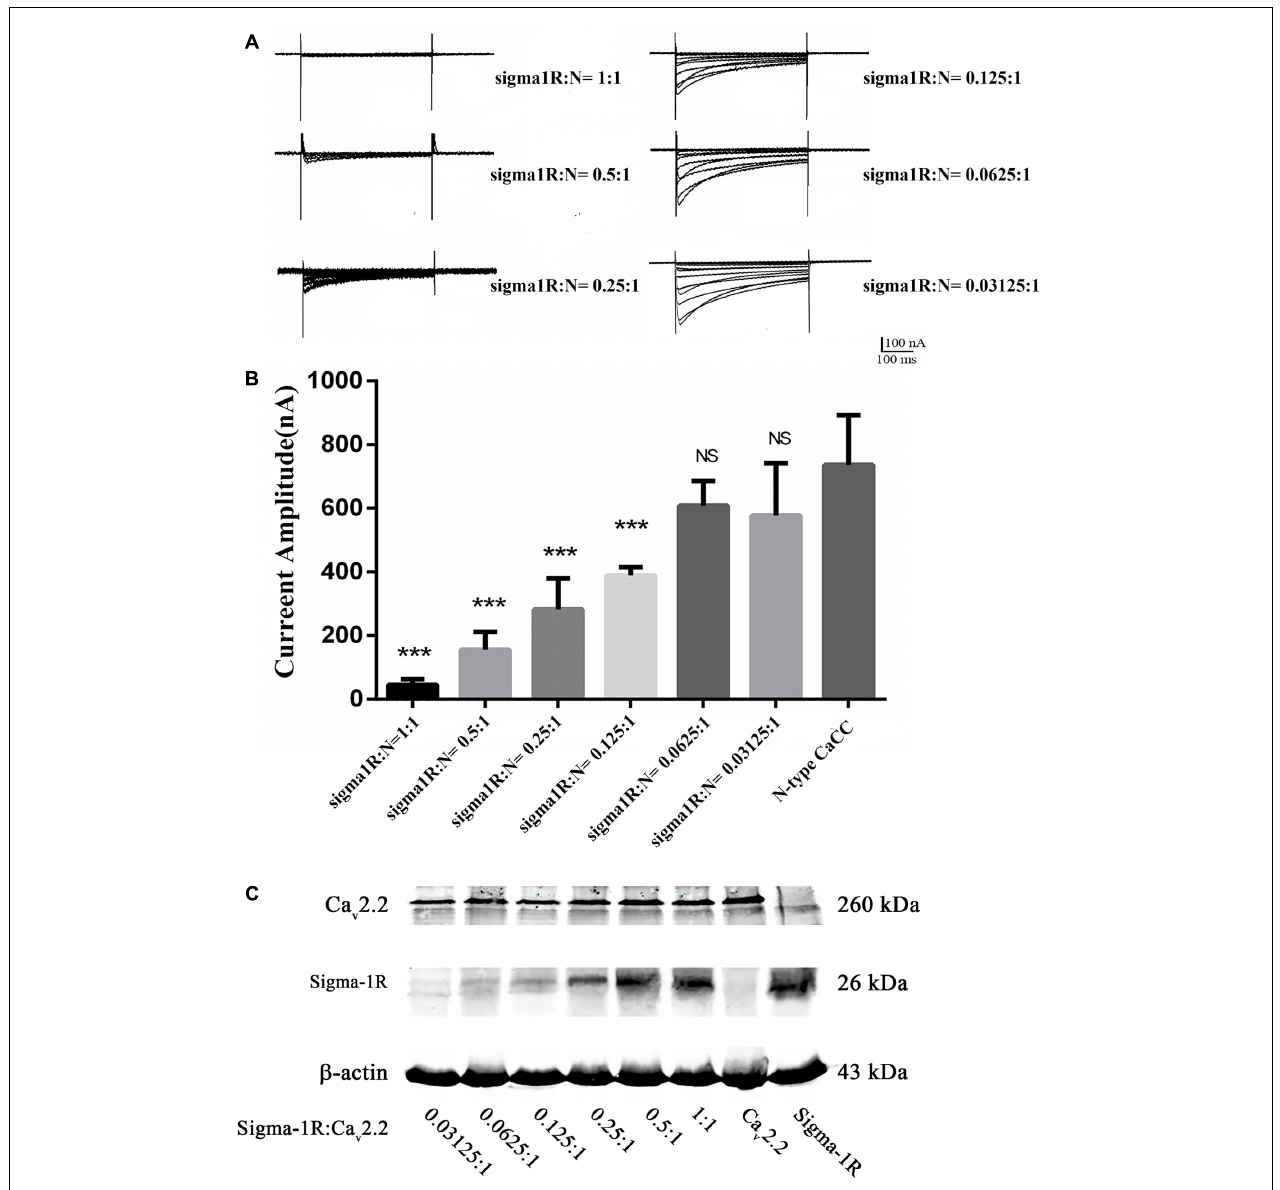
FIGURE 4 | Currents recorded at different cRNA ratio of sigma-1 receptor to N-type Ca 2 + channel. (A) Currents recorded from the oocytes injected with different cRNA ratio. The cRNA concentration ratio of Sigma-1 receptor: N-type Ca 2 + channel = 1:1, 0.5:1, 0.25:1, 0.125:1, 0.0625:1, and 0.03125:1, respectively. (B) Summarized bar graph to present the N-type Ca 2 + currents decreased with the increase of sigma-1 receptor cRNA injected in oocytes. The current amplitude recorded from oocytes with injection of N-type Ca 2 + channel cRNA only was normalized as 100%. Values are Mean ± SEM ( n = 18 for 1:1, n = 18 for 0.5:1, n = 17 for 0.25:1, n = 26 for 0.125:1, n = 17 for 0.0625:1, and n = 10 for 0.03125:1 group, respectively. ∗∗∗ p < 0.001, ∗ p < 0.05). (C) The expression levels of the two proteins from oocytes injected with the cRNA ratio of sigma-1 receptor: N-type Ca 2 + channel at 0.03125:1, 0.0625:1, 0.125:1, 0.25:1, 0.5:1, and 1:1 from left to right. The blots in the right two lanes showed the protein expression in oocytes of control groups, which were injected with the N-type Ca 2 + channel cRNA or the sigma-1 receptor cRNA alone.